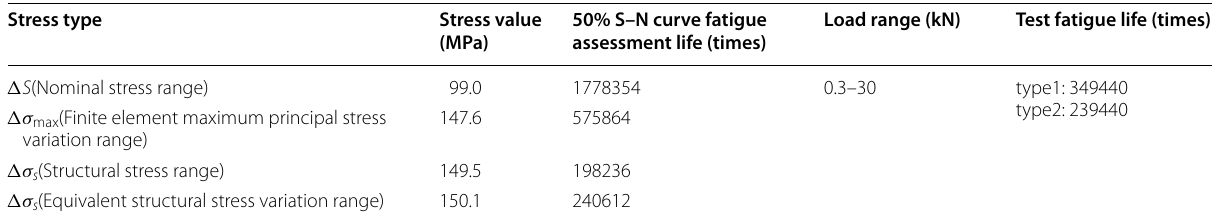
Table 9 Comparison of fatigue test results and evaluation of life of butt test specimens Stress type